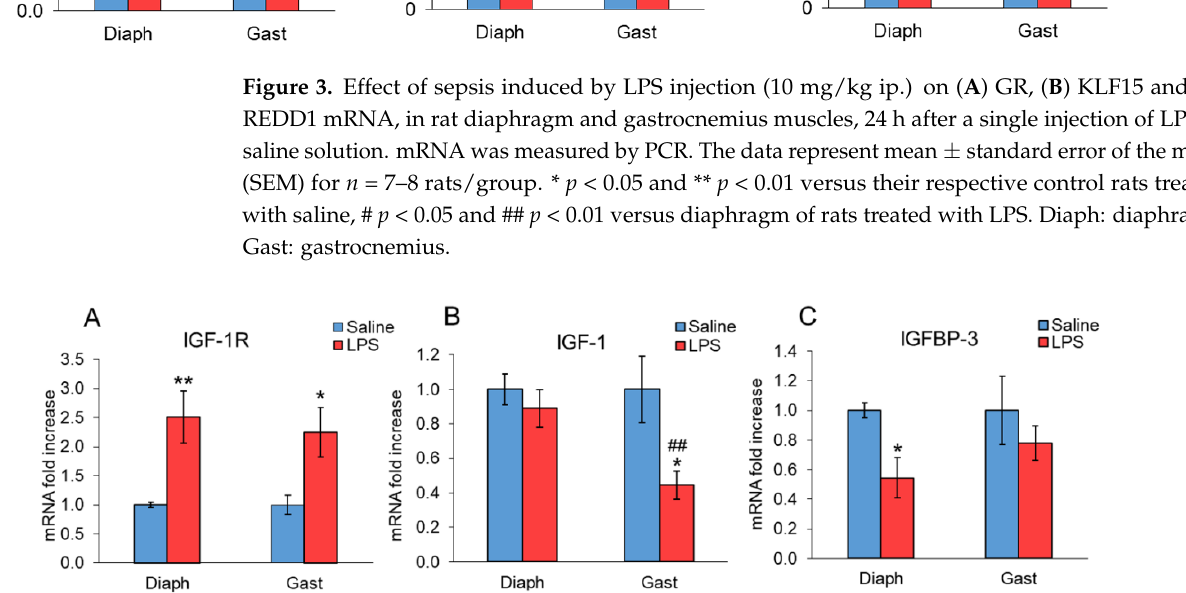
Figure 3. Effect of sepsis induced by LPS injection (10 mg/kg ip.) on ( A ) GR, ( B ) KLF15 and ( C ) REDD1 mRNA, in rat diaphragm and gastrocnemius muscles, 24 h after a single injection of LPS or saline solution. mRNA was measured by PCR. The data represent mean ± standard error of the mean (SEM) for n = 7 – 8 rats/group. * p < 0.05 and ** p < 0.01 versus their respective control rats treated with saline, # p < 0.05 and ## p < 0.01 versus diaphragm of rats treated with LPS. Diaph: diaphragm, Gast: gastrocnemius.